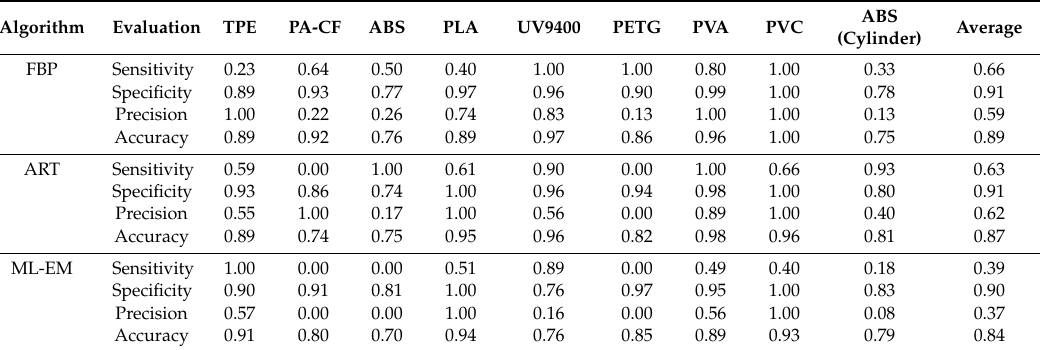
Table 6. Evaluation parameters of prediction result by ANN.